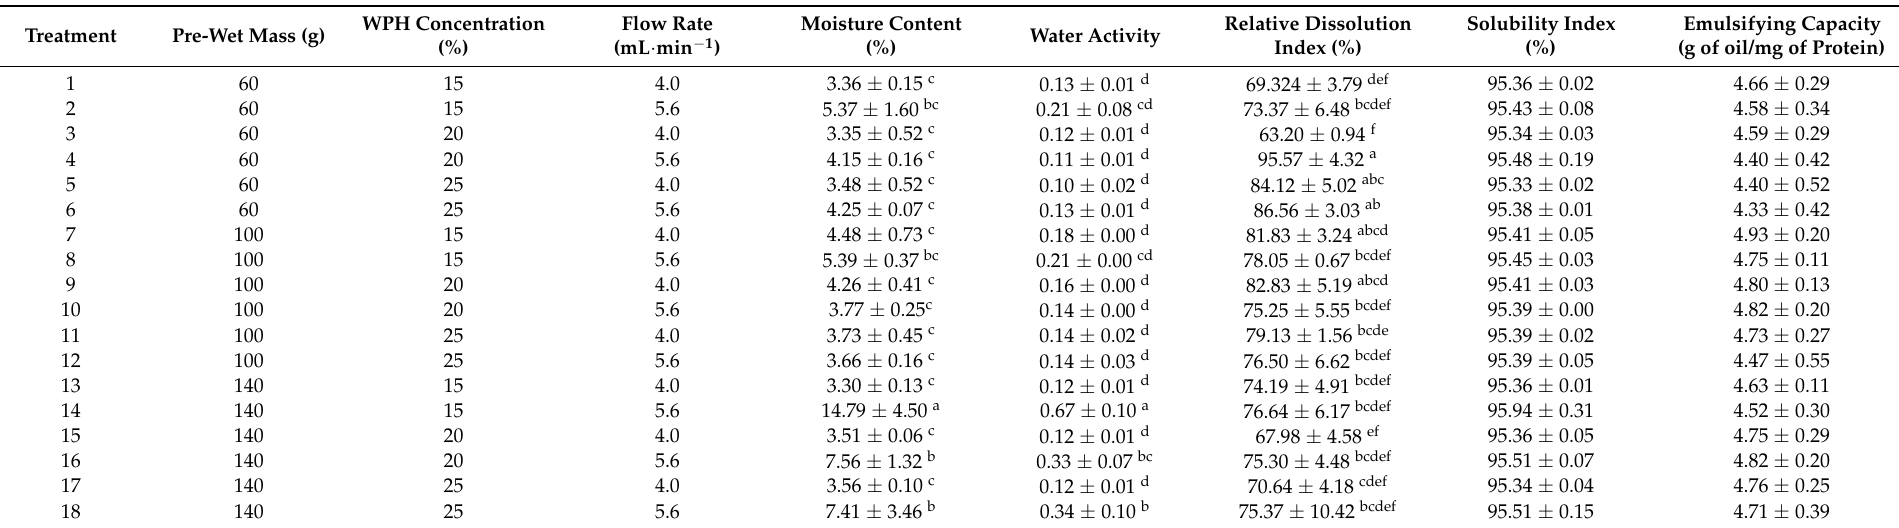
Table 4. Moisture content (%), water activity, solubility index (%), emulsifying capacity (g of oil/mg of protein), and relative dissolution index of all agglomerated WPI treatments as per experimental